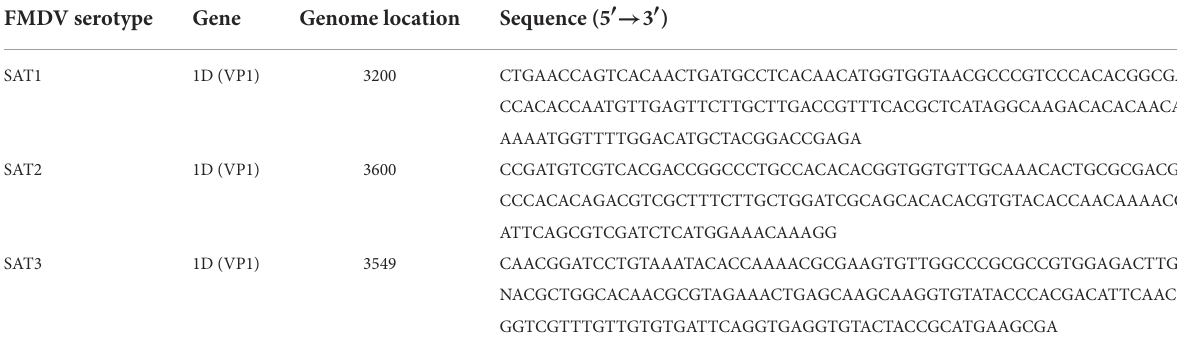
TABLE 1 Top ranking FMDV SAT1, SAT2 and SAT3 serotype-specific genetic signatures generated by Neptune version 1.2.5 software. FMDV